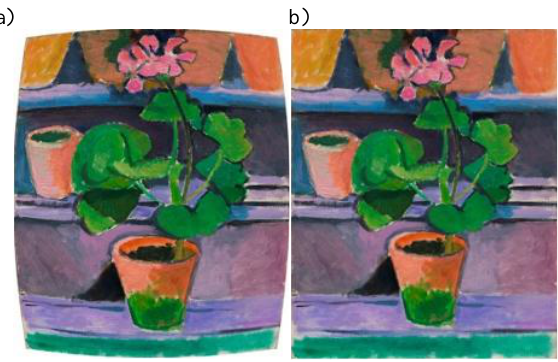
Figure 3. Result of the camera calibration: a) input image; b) output images corrected for lens distortion